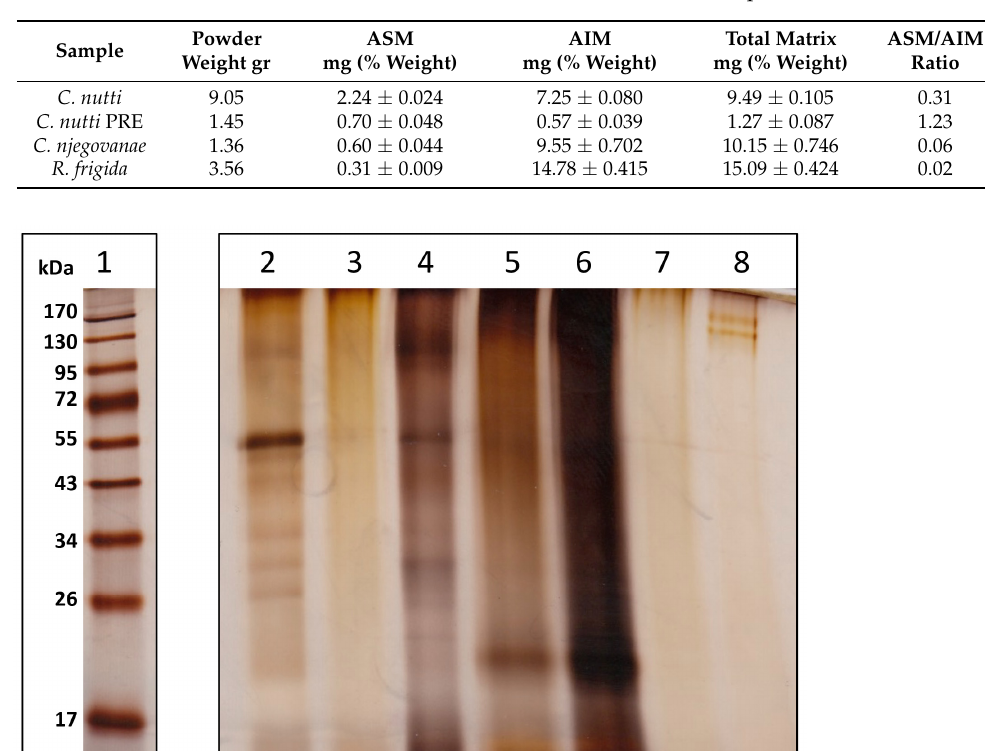
Table 4. Quantification of powder weight (g), ASM and AIM, total matrix (% weight ± s.d.) and ASM/AIM extracted from Cellarinella nutti , C. nutti PRE, Cellarinella njegovanae and Reteporella frigida skeletons. ASM: Acid-soluble matrix. AIM: Acid-insoluble matrix. PRE = pre-bleached.